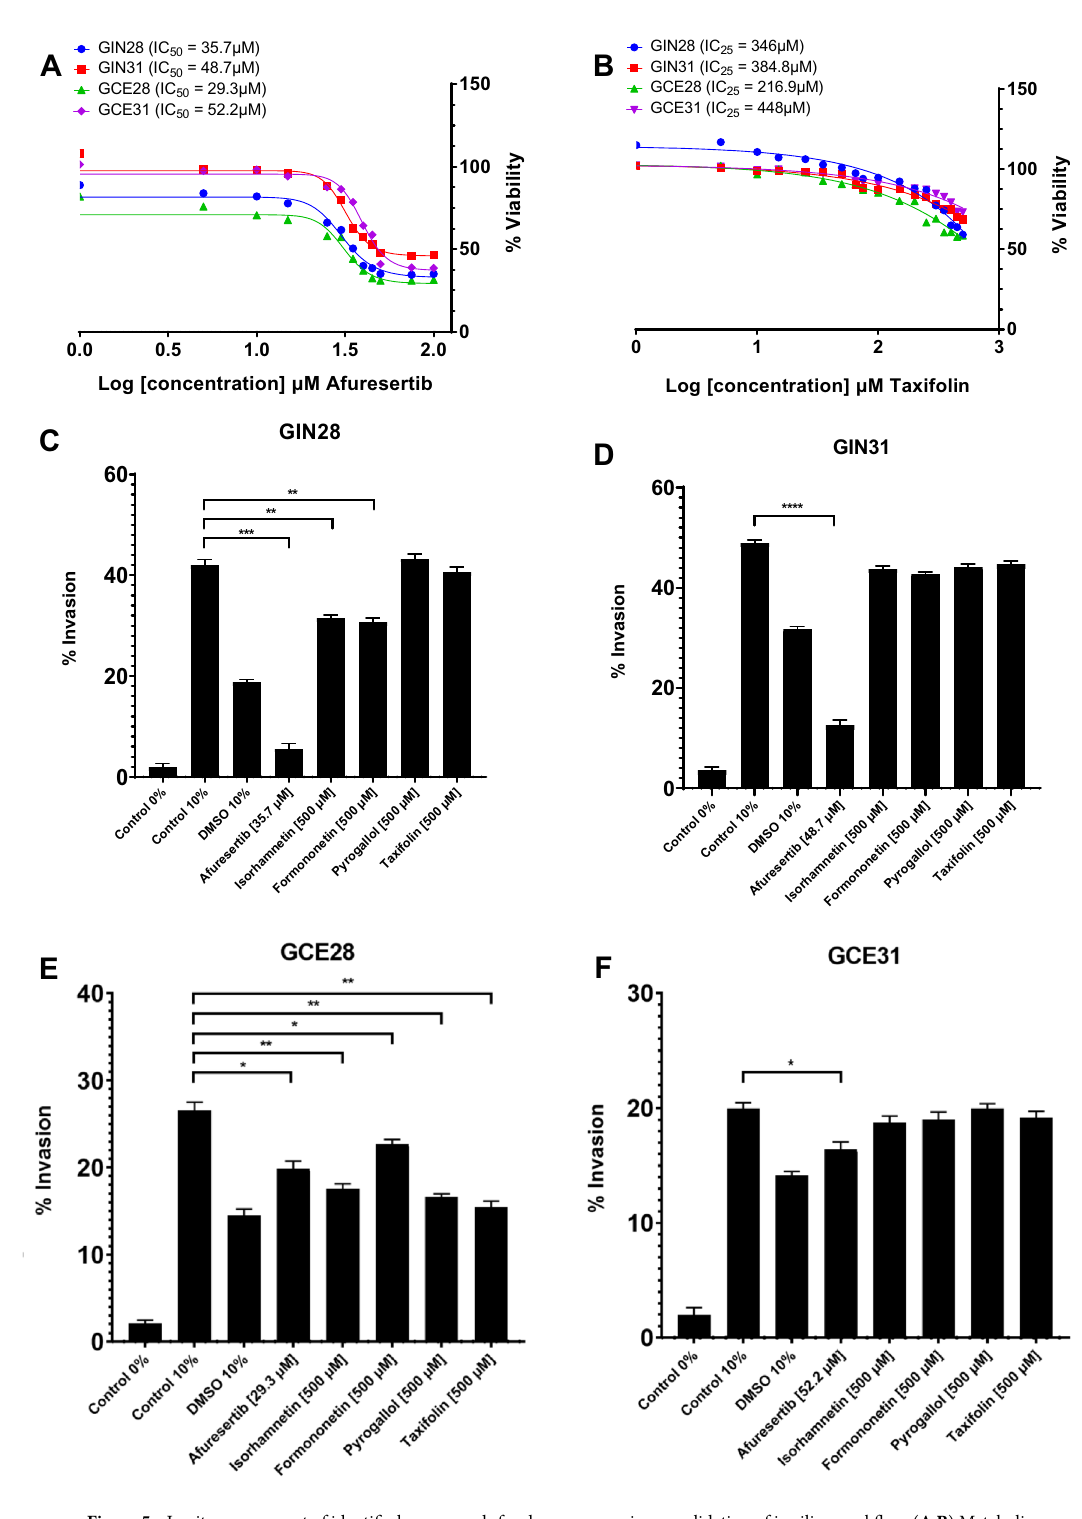
Figure 5. In vitro assessment of identified compounds for drug repurposing as validation of in silico workflow. ( A , B ) Metabolic viability was assessed for afuresertib ( A ) and taxifolin ( B ) in a 96-well 16-point dose response assay across four patient-derived GBM lines. PrestoBlue was used to assess metabolic viability after 72 h and data is presented as the mean percent viability compared to DMSO-treated controls (n = 6). Afuresertib was identified as the most potent drug inhibiting proliferation at IC 50 values of 35.7 μM, 48.7 μM, 29.3 μM and 52.2 μM for the GIN28, GIN31, GCE28 and GCE31 cell lines, respectively ( A ). Taxifolin showed a modest but significant effect on cell sensitisation generating IC 25 values of 346 μM, 384.8 μM, 216.9 μM, 448 μM on GIN28, GIN31, GCE28 and GCE31 cell lines, respectively ( B ). ( C – F ) Effects on invasion in GBM invasive margin (GIN28, GIN31) and GBM Contrast-Enhanced core (GCE28, GCE31) cell lines following treatment with four compounds at 500 μM and afuresertib at IC50 concentration. Invasion towards 0% FBS (Control 0%) on untreated cells and DMSO treated (DMSO 10%) controls were also included. Data is presented as mean percent invasion ± SEM compared to number of seeded cells after 24 h incubation. Significance was tested by one-way ANOVA (*p < 0.05, **p < 0.01, ***p < 0.001, **** p < 0.0001) comparing each data set to control 10% (invasion towards 10% FBS; n =